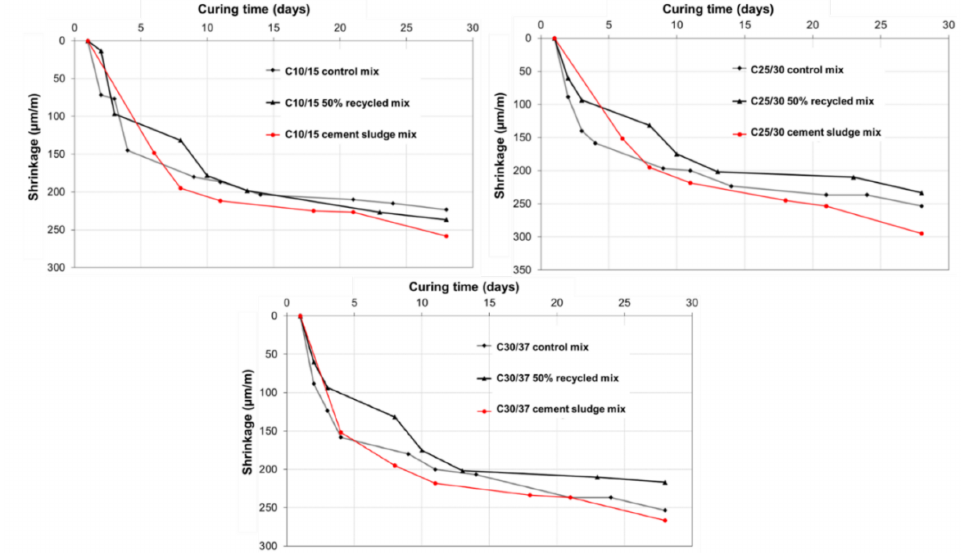
Figure 7. Hygrometric shrinkage of concrete samples at different curing